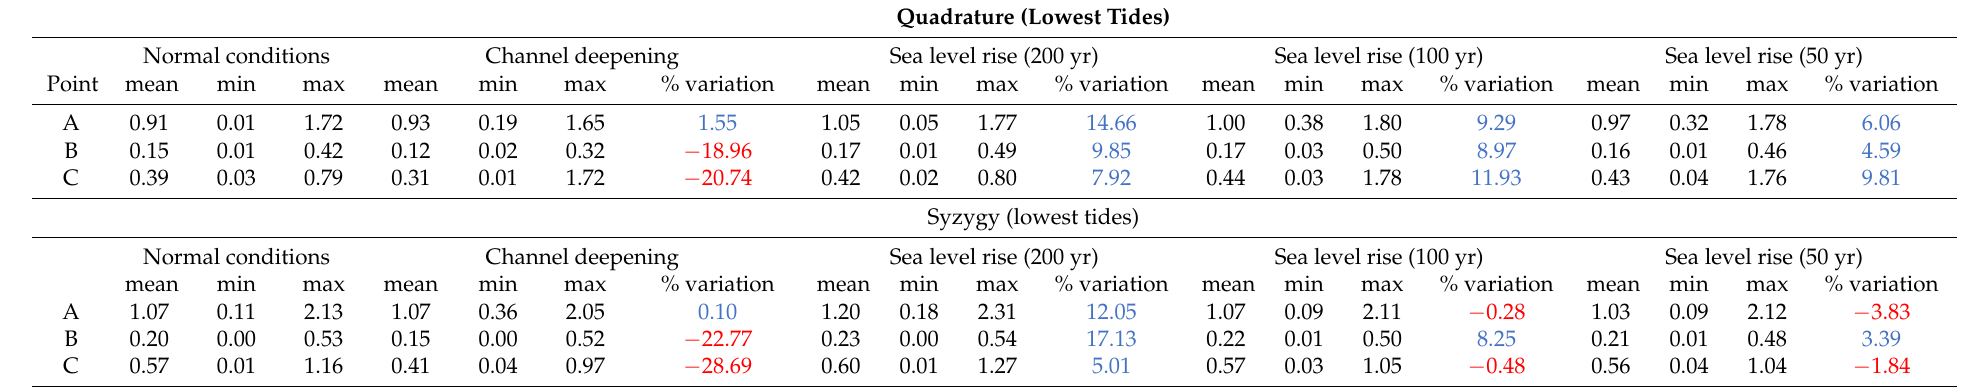
Table 4. Statistics of modeled velocity currents for the highest Syzygy and lowest Quadrature of 2021 in Buenaventura Bay. Red-blue colors represent decrement- increment of velocity with respect to normal conditions. The label % variation represents de increment or decrement of velocity currents with respect to normal